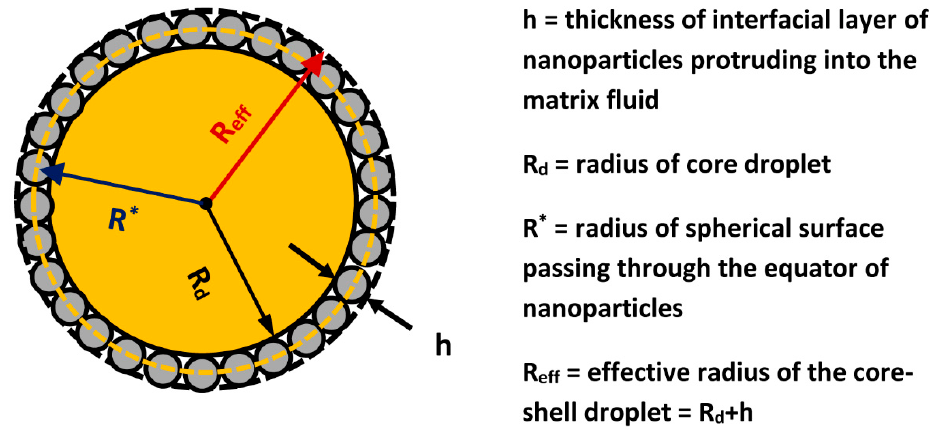
Figure 10. Schematic diagram of a Pickering emulsion droplet with relevant dimensions.